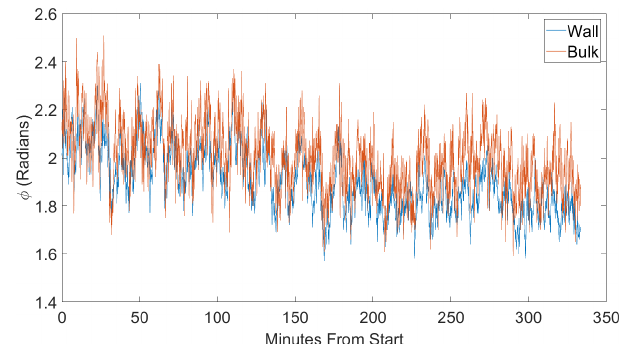
Figure 7. The azimuthal orientation ( φ ) of the large-scale circula- tion for a (cid:49)T = 12K along the wall (red) and 30cm towards the center (blue). φ is essentially the same for both rings of temperature sensors.